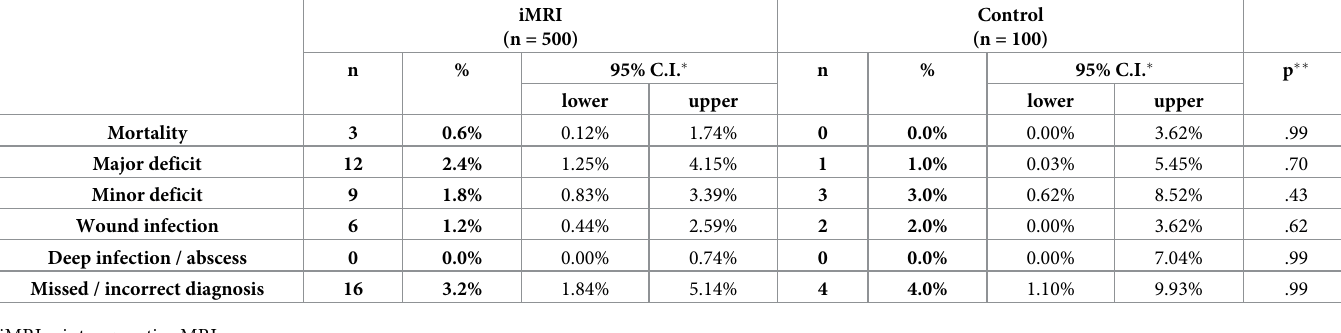
Table 5. Summary of